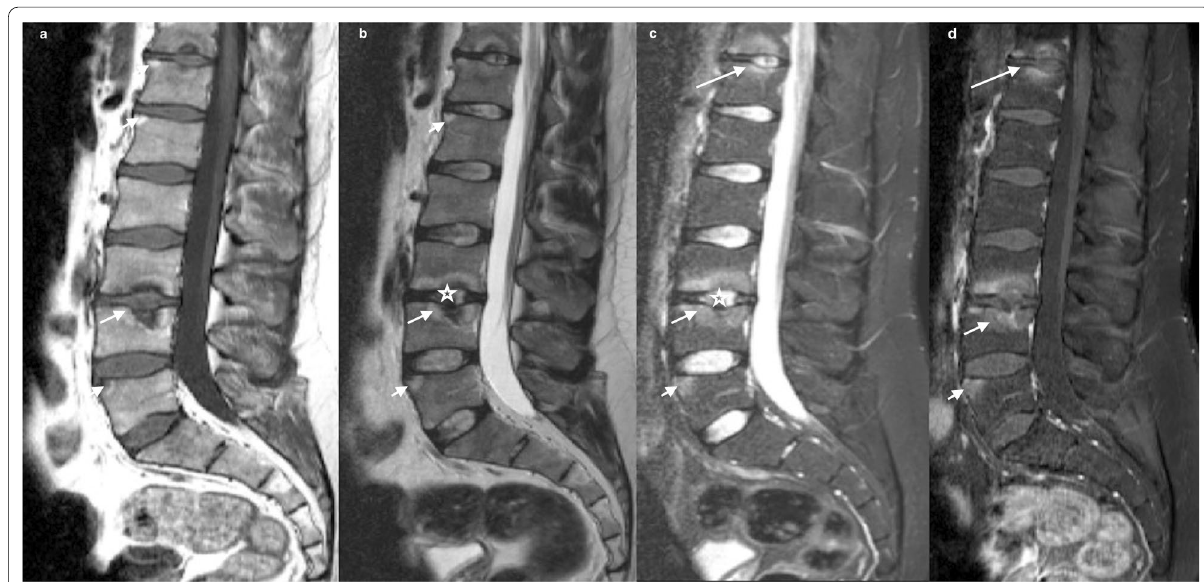
Fig. 2 32-year-old male admitted for exacerbation of back pain and inflammatory markers. T1 ( a ), T2WI ( b ), and STIR- R1 point 7 ( c ) show inflammatory endplate changes at the L3–L4 level mimicking a Schmorl node (arrow). Note that nuclear cleft sign is preserved (star). Enhancement in T1 fat-suppressed sequence after contrast ( d ) without disc enhancement or inflammatory paraspinal tissue. The same pattern is seen in the D11– D12 disc space (long arrow), associated with Romanus feature R1 point 8 at L5 body margin (short